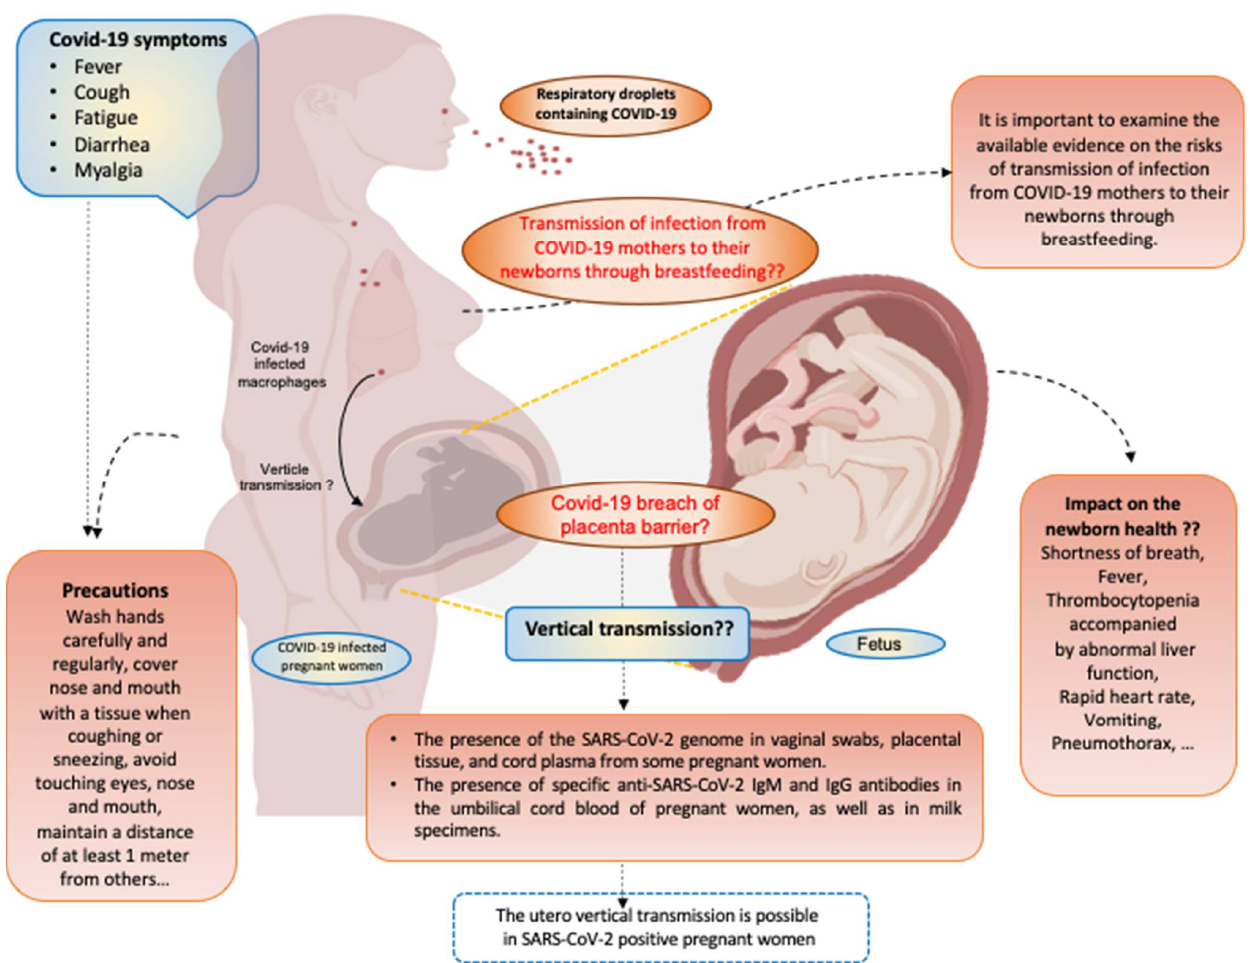
Figure 1. COVID-19 infection during pregnancy. Schematic model presenting the relationship between COVID-19 and pregnant women. Pregnant women acquire COVID-19 via respiratory droplets. COVID-19 is spread throughout the maternal vasculature and the symptoms appear after an incubation period of approximately 5.2 days. The most common symptoms of COVID-19 are fever, dry cough, fatigue, diarrhea, and myalgia. The impact of COVID-19 infection on pregnancy outcomes are not established. However, COVID-19 infection effects newborn health (shortness of breath, fever, and thrombocytopenia accompanied by abnormal liver function, rapid heart rate, vomiting, pneumothorax, etc.). So far, the vertical transmission from the woman to her baby may be possible, but no data related to the risks of transmission of COVID-19 infection through breastfeeding were recorded. Specific precautions (wash hands carefully and regularly, cover nose and mouth with a tissue when coughing or sneezing, avoid touching eyes, nose and mouth, maintain a distance of at least 1 m from others, etc.) are needed to protect both the mother and her baby. Figure was created with BioRender.com